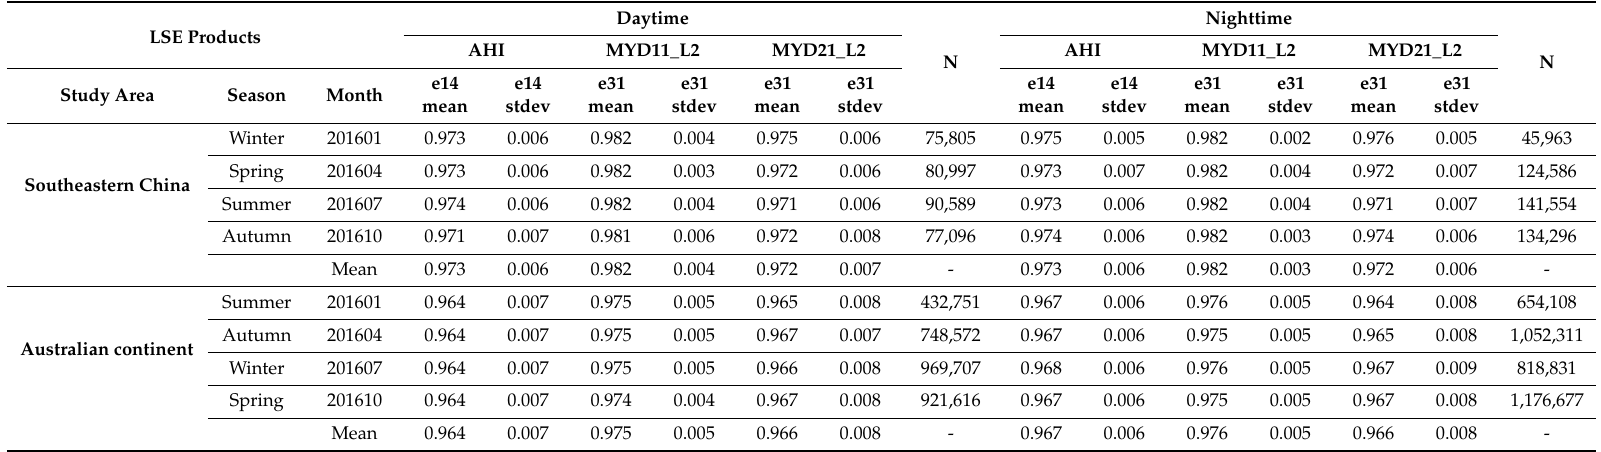
Table 11. Statistics of emissivity in AHI band 14 and MODIS band 31 of the MYD11 and MYD21 products over the two study areas during the daytime and